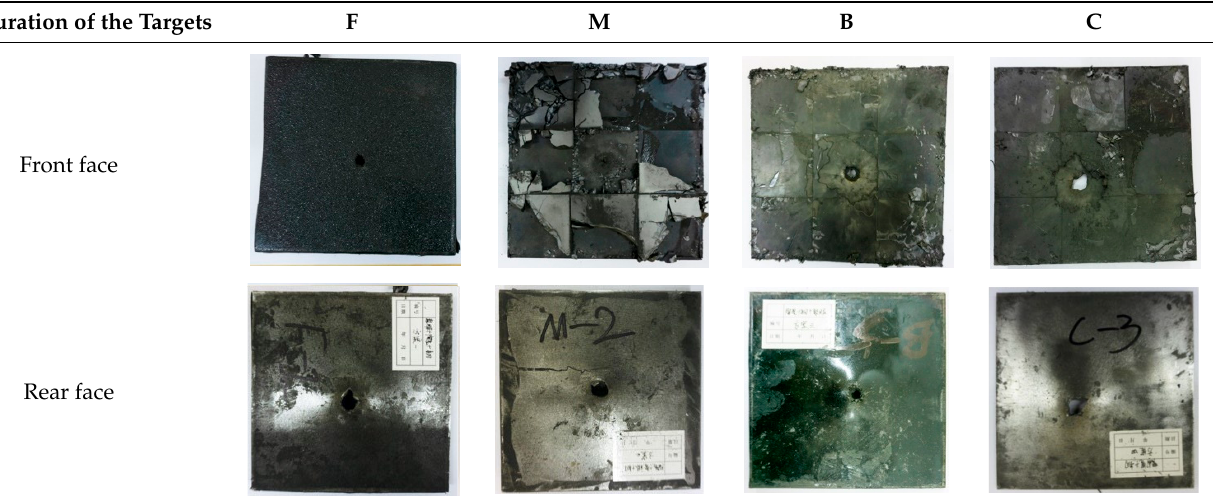
Table 5. Damage characteristics of the targets after penetration.